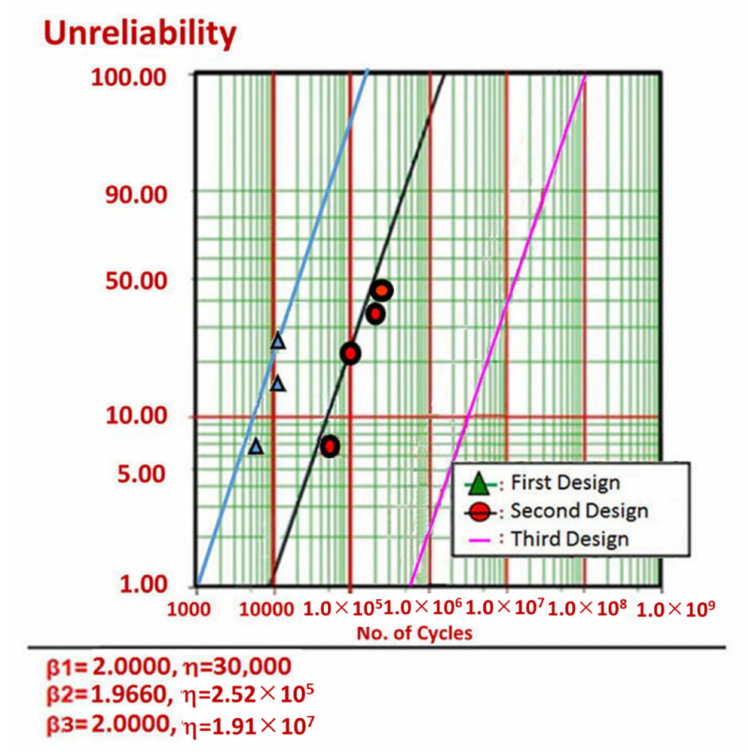
Figure 15. Result of ALT on Weibull chart. Table 4. Pneumatic cylinder ALT